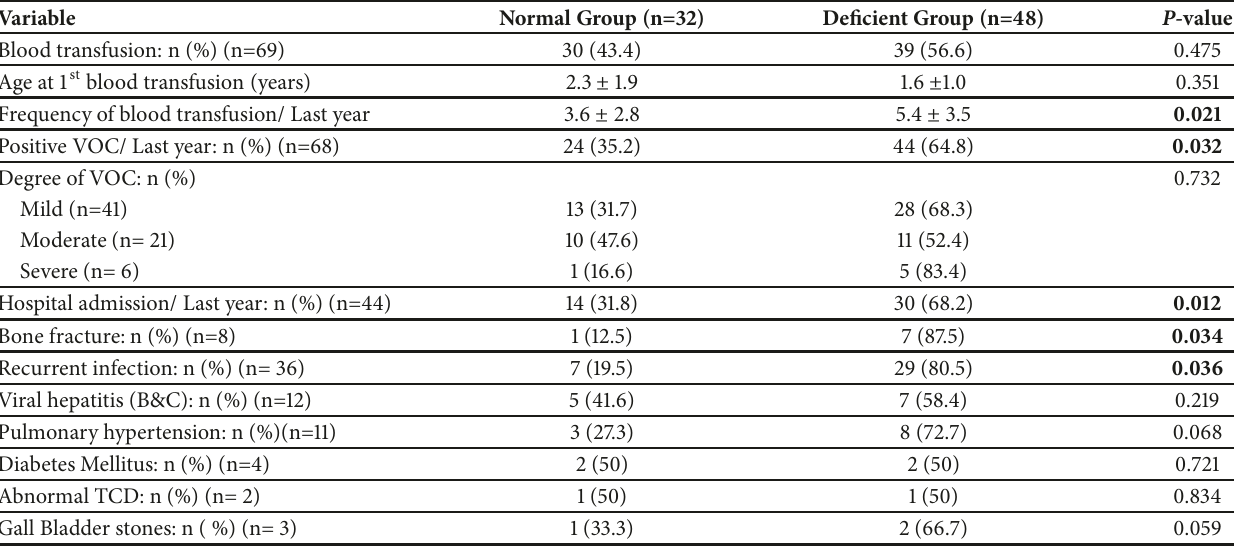
Table 5: Association between VDD, clinical course, and complications of